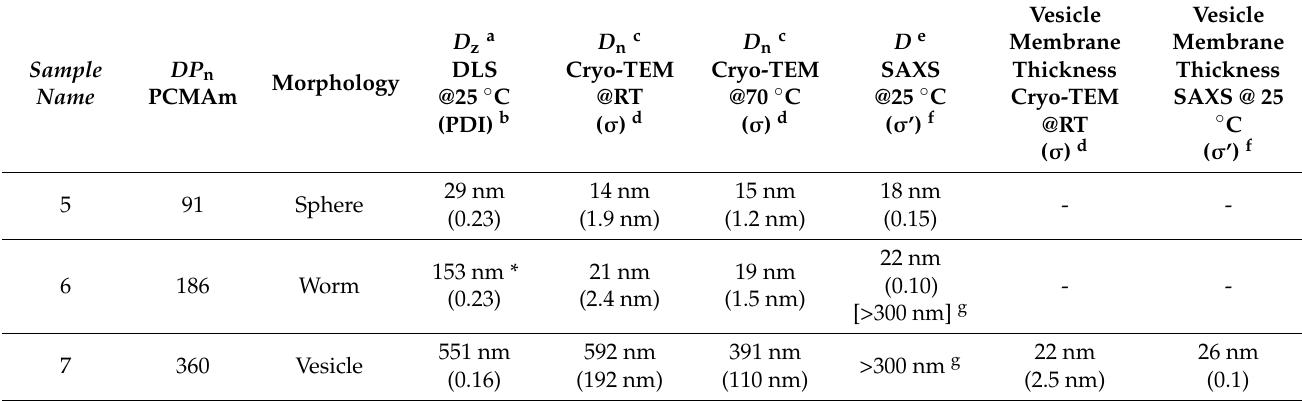
Table 2. Dimensions of the cylindrical micelles deduced from DLS measurements, cryo-TEM analyses and the fit of SAXS